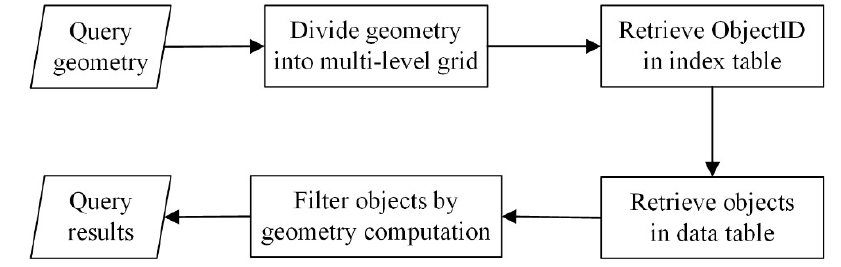
Figure 11. Flowchart of the spatial query.